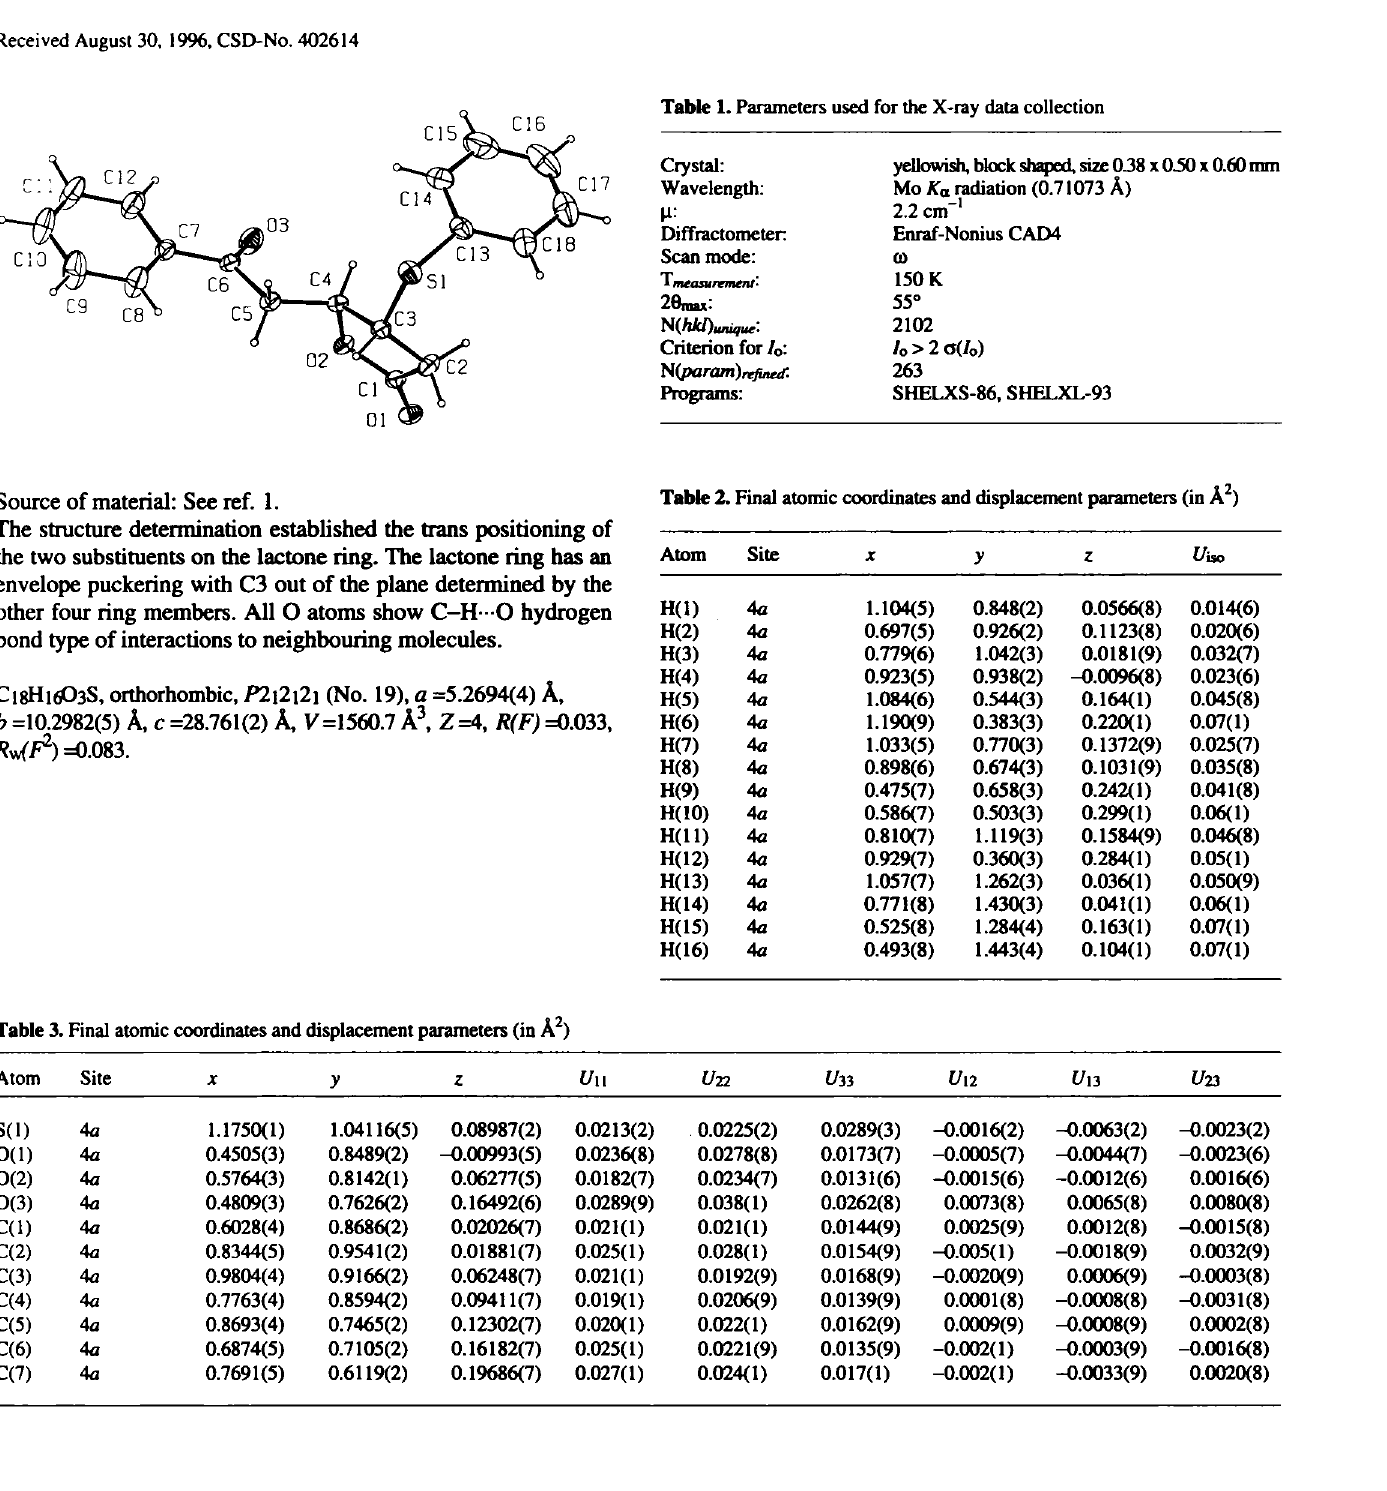
Table 1. Parameters used for the X-ray data collection Crystal: